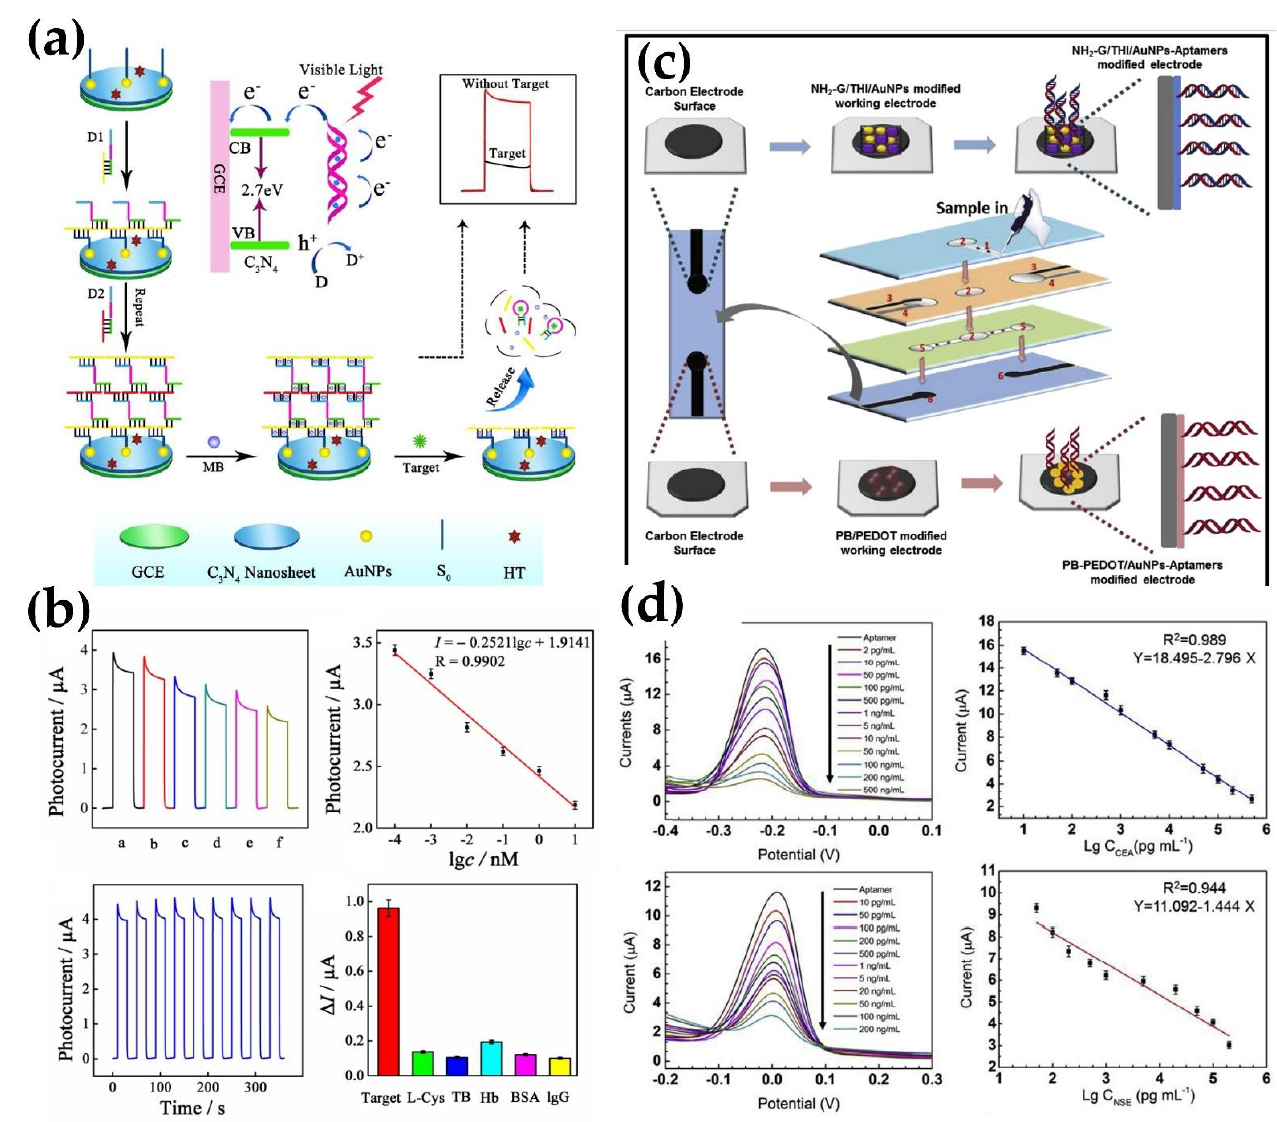
Figure 4. Aptasensor for lung cancer diagnostics. ( a , b ) Photoelectrochemical (PEC) aptasensor. ( c , d ) A paper-based electrochemical aptasensor. Reprinted with permission from Refs. [68,76]. Copyright 2018, 2019 Elsevier.